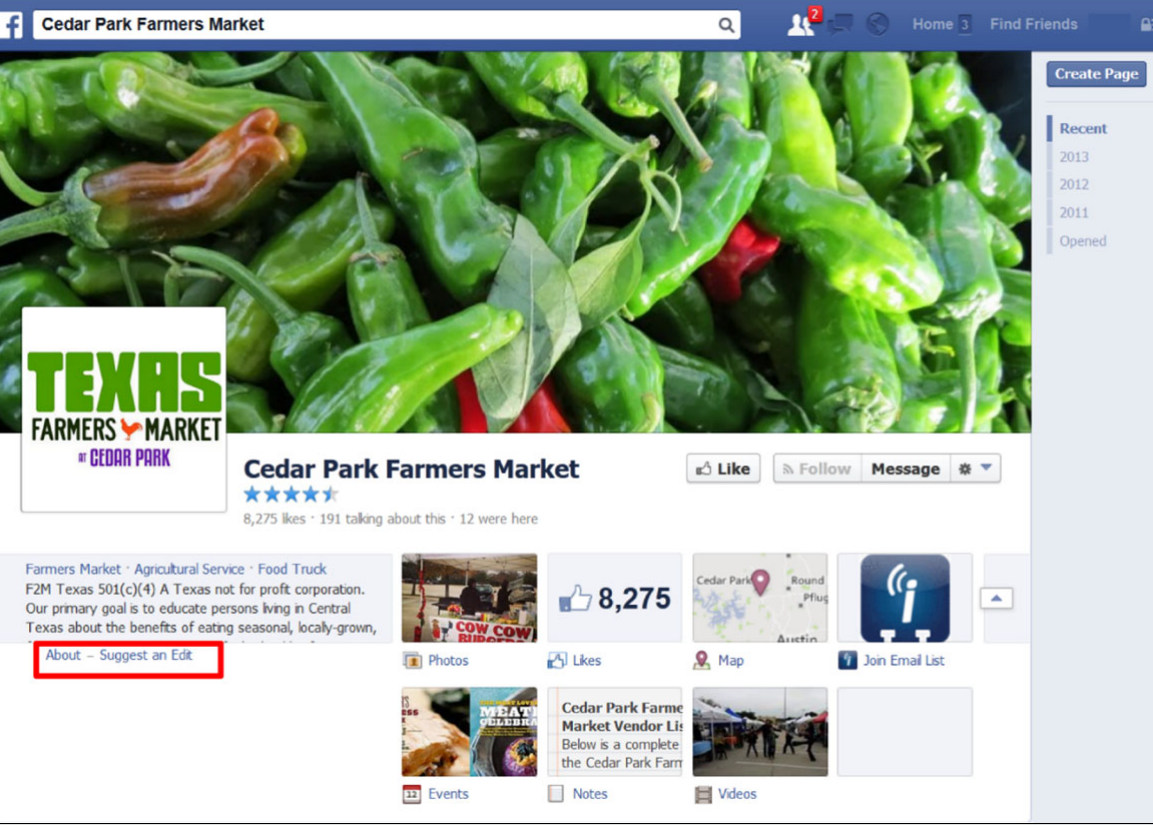
Figure 2. Header of Cedar Park Farmers Market’s Facebook Page (Captured on December 22,